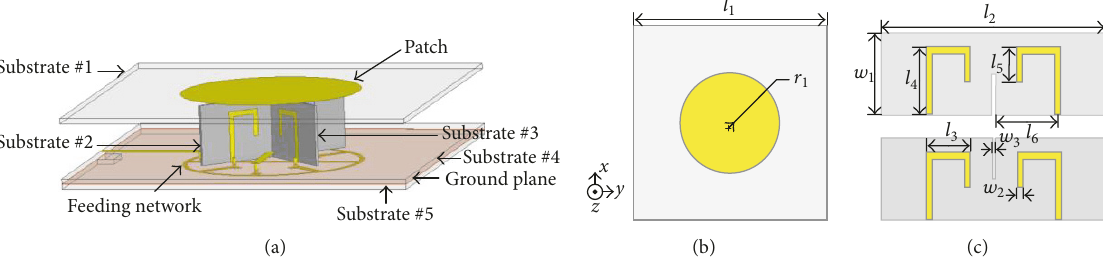
Figure 6: Geometry of the proposed antenna. (a) Perspective view of the antenna. (b) Structure of substrate #1. (c) Structure of substrates #2 and #3. 𝑙 1 = 105 mm, 𝑙 2 = 50 mm, 𝑙 3 = 10 mm, 𝑙 4 = 15 mm, 𝑙 5 = 8 mm, 𝑙 6 = 13.9 mm, 𝑤 1 = 18 mm, 𝑤 2 = 1.5 mm, 𝑤 3 = 0.8 mm, and 𝑟 = 27 mm. 1